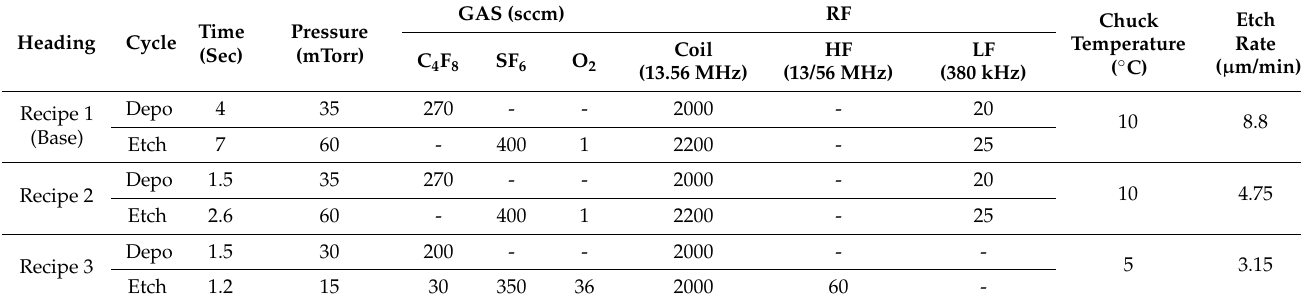
Table 1. DRIE process condition recipes for different vertical etching depths.